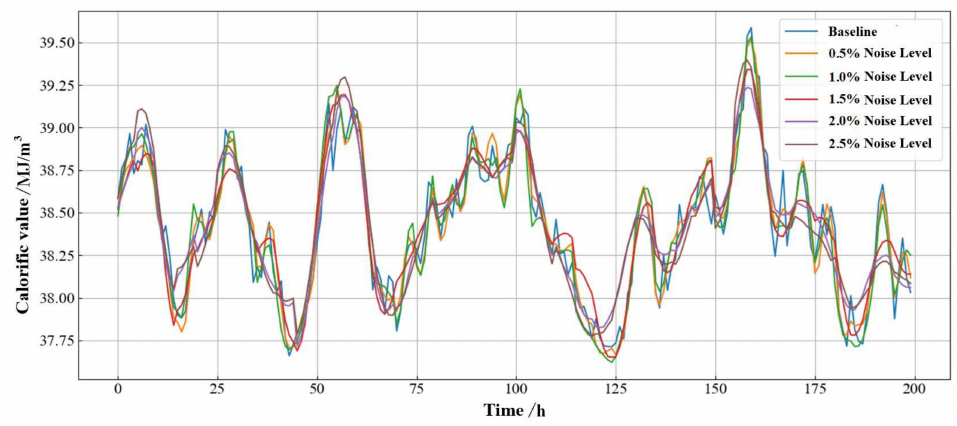
Figure 14. Prediction results of calorific value under different noise levels.